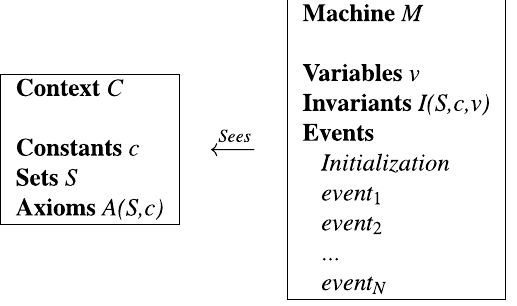
Table 6. General structure of machine M and context C in